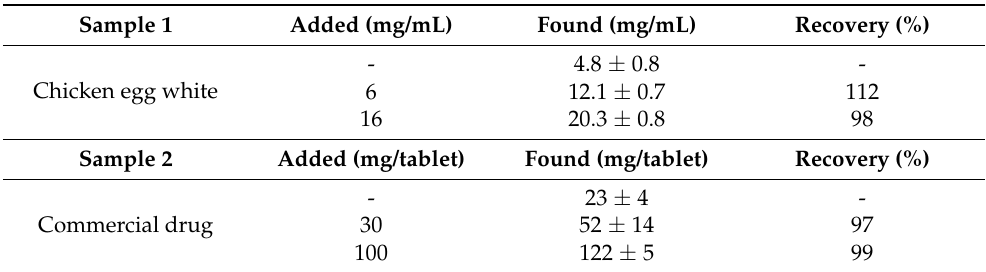
Table 2. Analysis that was performed for the determination of LYS in real